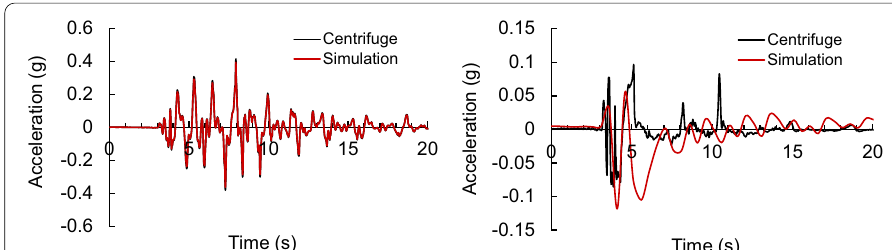
Fig. 8 Comparison of numerical and experimental results for acceleration at bottom of model (left) and ‑2 m from top (right)